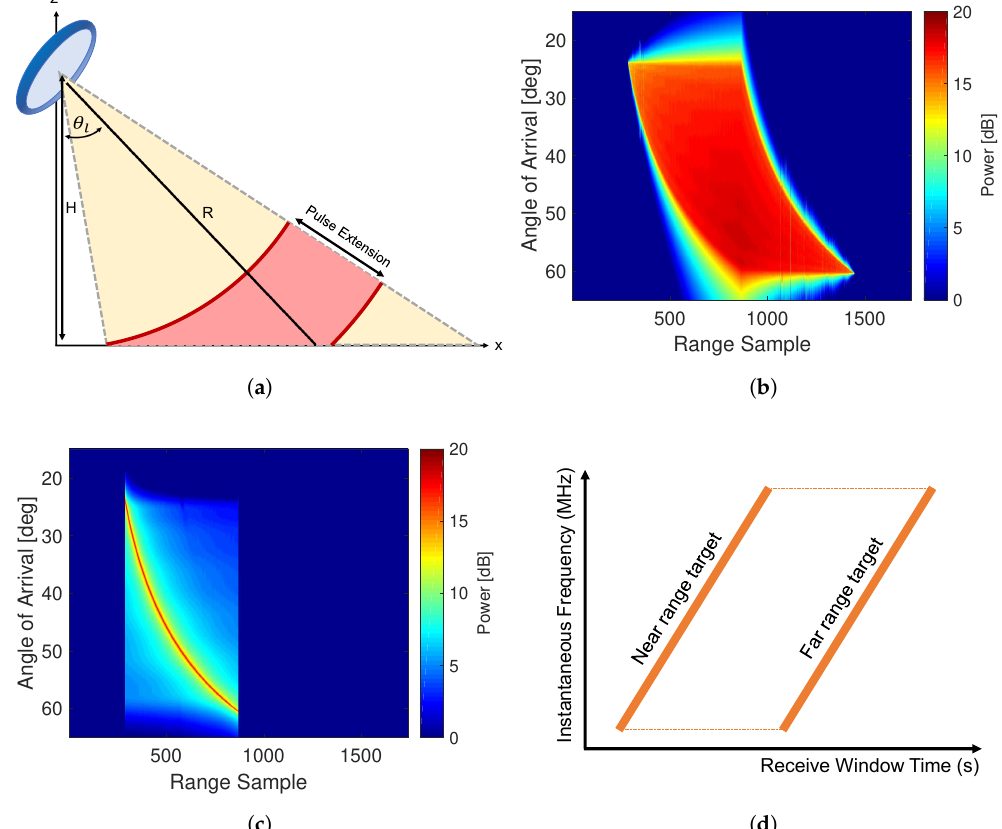
Figure 1. ( a ) Illustration of the travelling pulse extension in red. Returns from all targets within the red zone arrive at the radar simultaneously. ( b ) Capon spatial spectrum (power from AoA) versus range sample for raw SAR signal. The radar is receiving energy from a wide span of AoAs at each range because of the pulse extension. ( c ) Capon spatial spectrum versus range sample for range-compressed SAR signal. The energy is compressed to the instantaneous range. ( d ) Instantaneous frequency of near and far range target within the receive window for a transmit pulse that is modulated with a linear frequency. The signals are simulated under the simulation conditions of Table 1 (Section